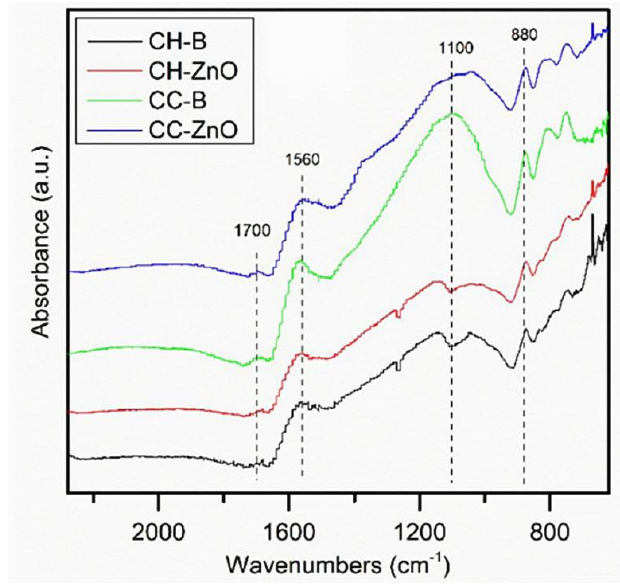
Figure 9. FT-IR spectra of CH-B, CH-ZnO, CC-B, CC-ZnO [112]. Reprinted with permission from